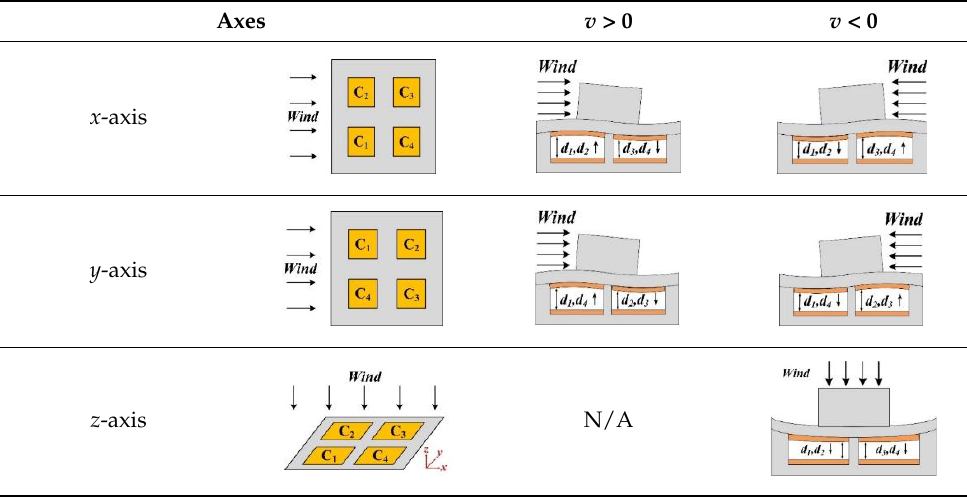
Table 1. Measurement principle along different axes.